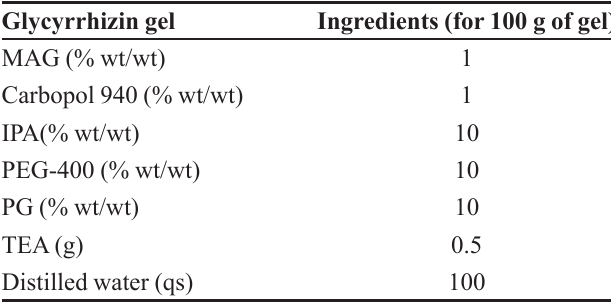
TABLE II - Formula for preparation of glycyrrhizin